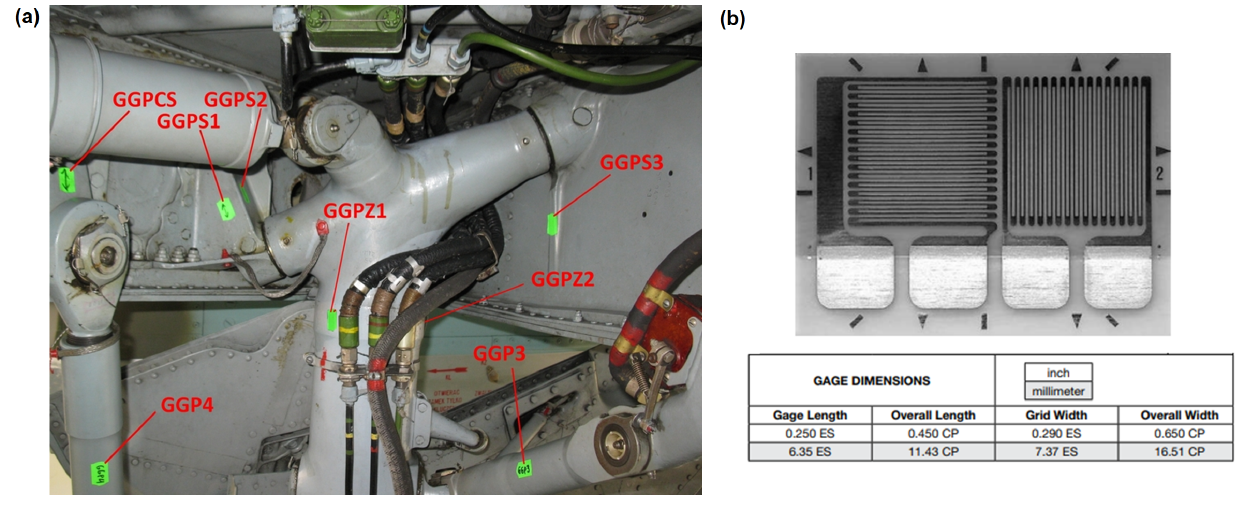
Figure 5. Localization and type of strain gauges installed on test aircraft: ( a ) localization of sensors in MLG compartment and ( b ) tee rosette strain gauges used (250UT manufactured by